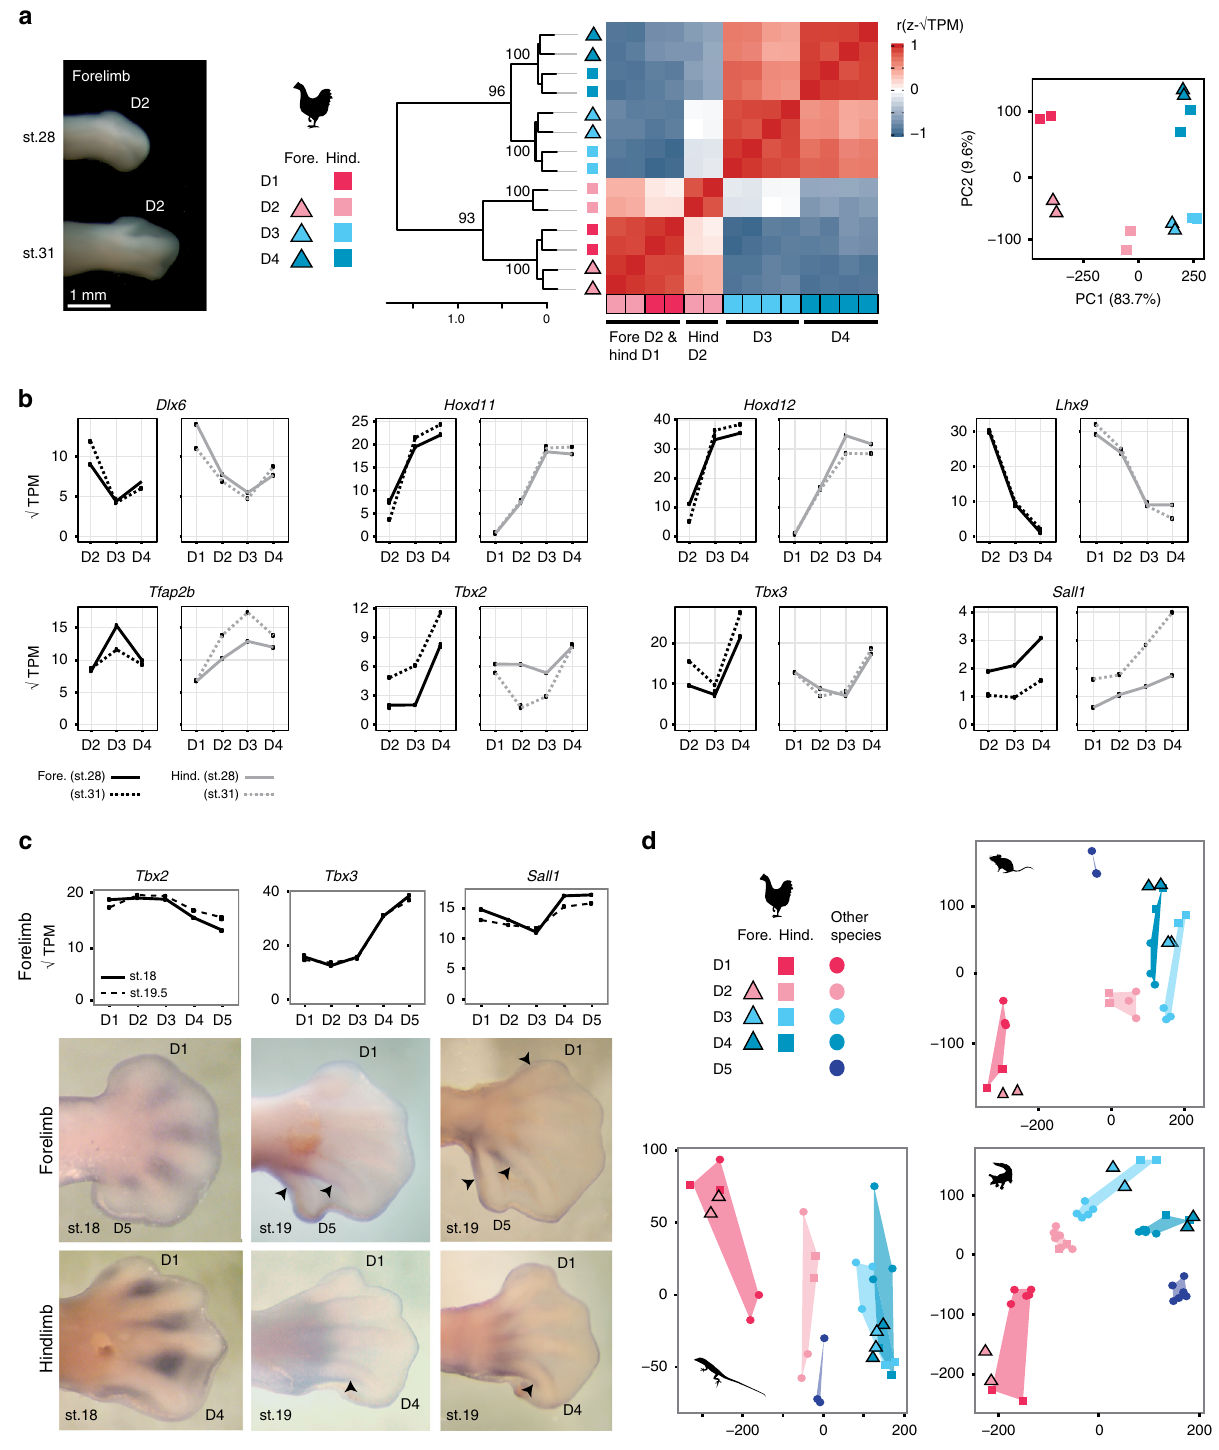
Fig. 6 Digits D2, D3, and D4 of the chicken forelimb correspond to D1, D3, and D4 of other limbs. This pattern is observed by a HCA and PCA of CDEGs for digits of chicken wing and hindlimb. b Expression levels of individual transcription factor genes in chicken. c In situ hybridization of alligator embryos con fi rms that the position of differential expression of transcription factors can be conserved between fore- and hindlimbs that differ in digit number. Arrowheads indicate distal-most expression along a developing digit. d Projection of chicken digit data upon PCA of CDEGs for mouse, alligator, and Anolis . TPM values shown in panels b and c calculated from the gene list of one-to-one orthologous genes between mouse, alligator, Anolis , chicken, and human. Source data for panel c are provided as a Source Data fi le. Alligator and chicken illustrations reproduced with permission by Michael Richardson.